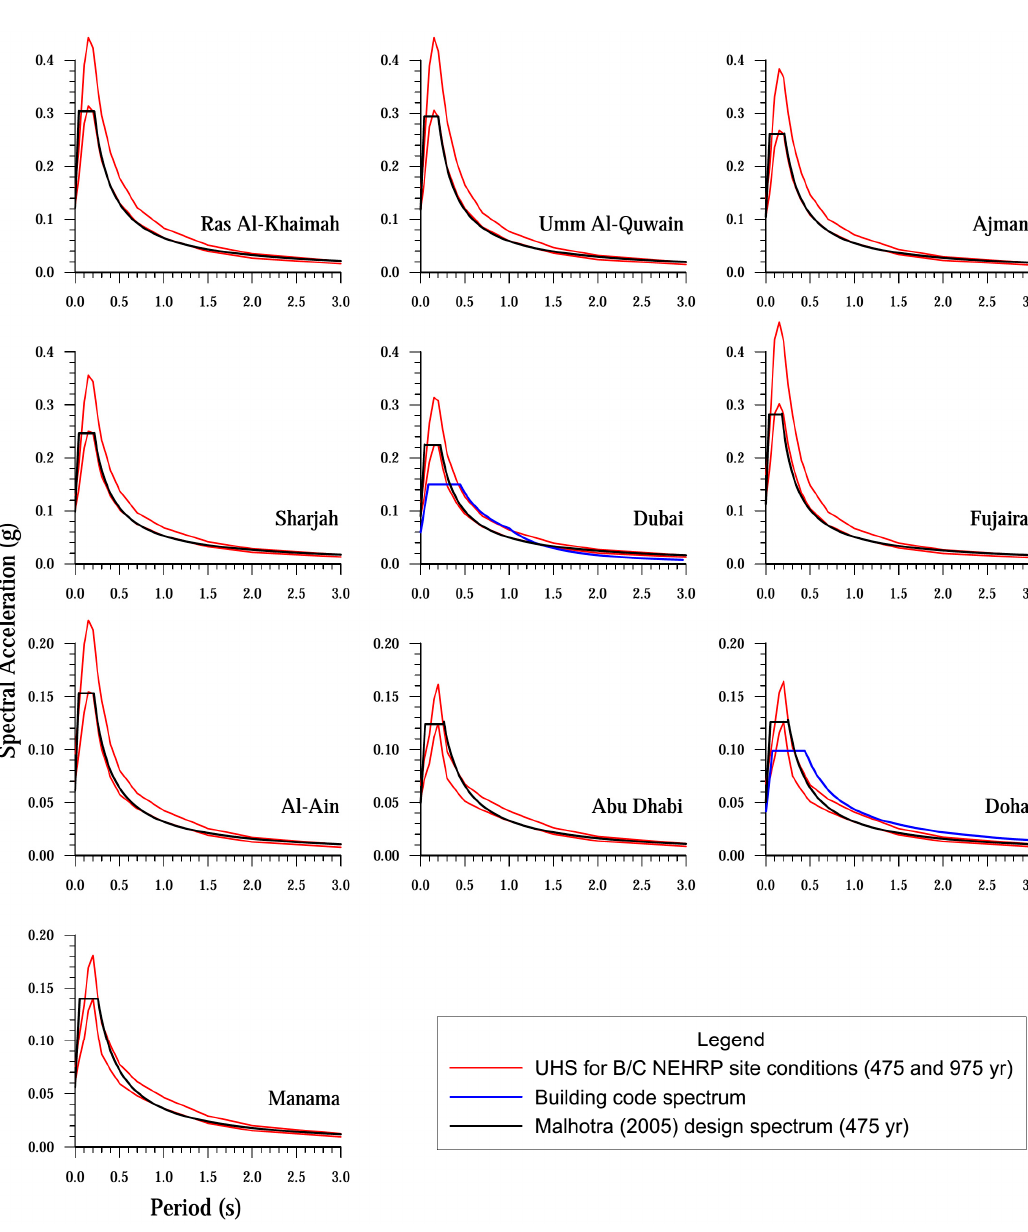
Figure 8. UHS and proposed Malhotra [106] design spectra, both for 5% damping ratio, for B/C NEHRP boundary site conditions and for return periods of 475 and 975 years, in comparison with the available building code regulations.